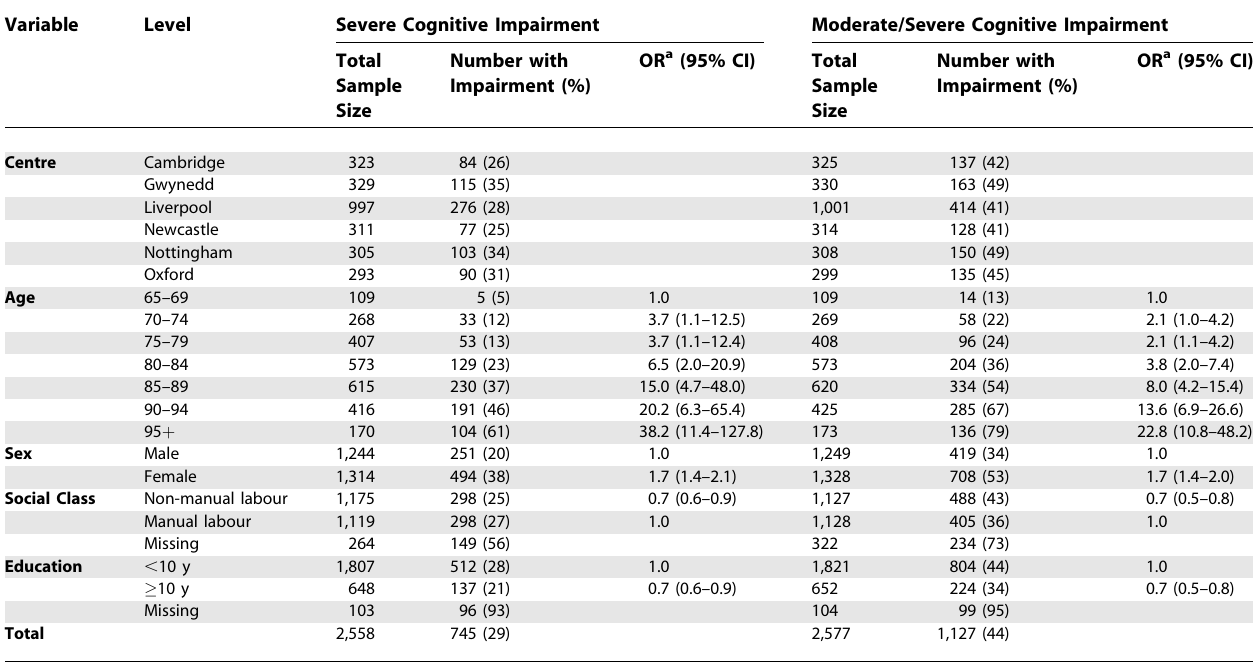
Table 2. Prevalence of Moderate and Severe Cognitive Impairment at Death and the Relationship with Potential Risk Factors Variable